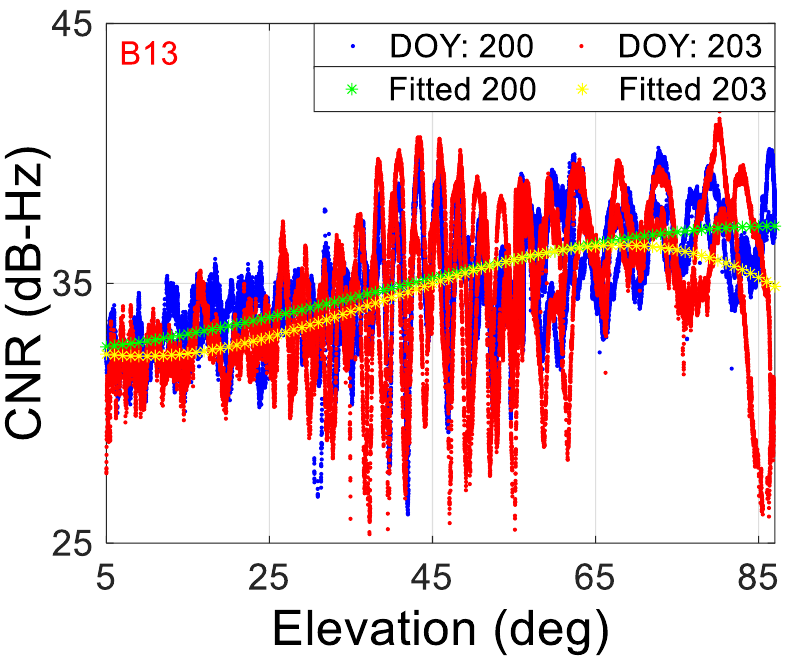
Figure 15. CNR of BDS IGSO B13 satellite B1 frequency comparison results with elevation as the horizontal axis. The blue and red dots denote the CNR collected on DOY:200 (no flood) and DOY:203 (with flood), 2021, respectively. The green and yellow lines are the fitted results of CNR on DOY:200 and DOY:203.